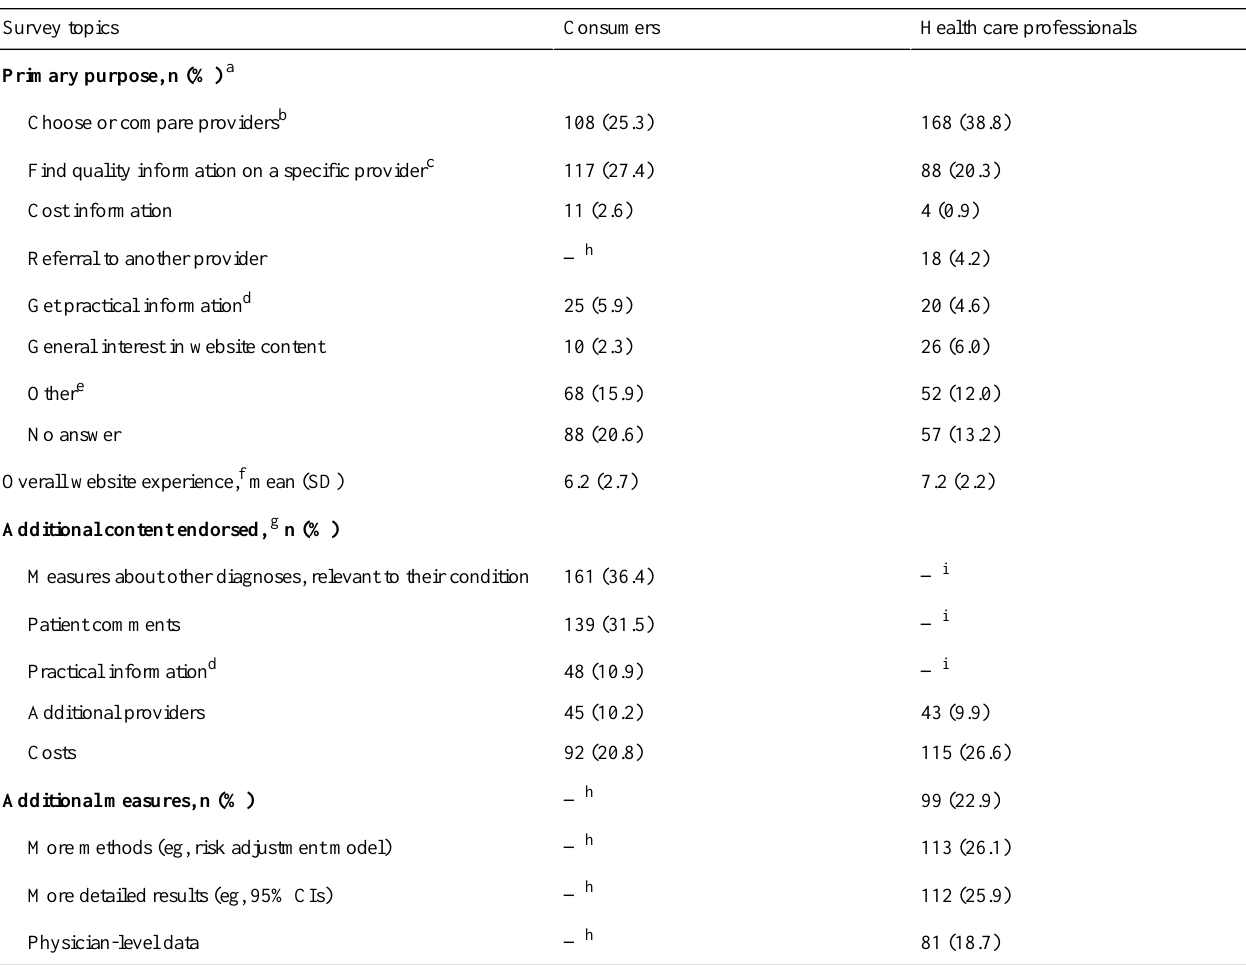
Table 3. Comparison of health care professionals’and consumers’primary purposes for visits to public reports and overall website